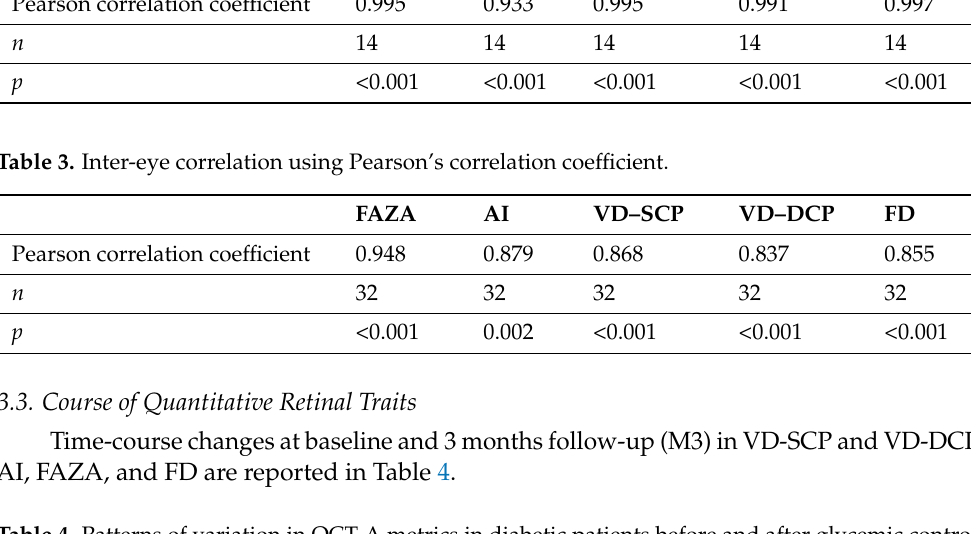
Table 4. Patterns of variation in OCT-A metrics in diabetic patients before and after glycemic control. Data presented as mean ( ± SD). Significant differences are underlined and in